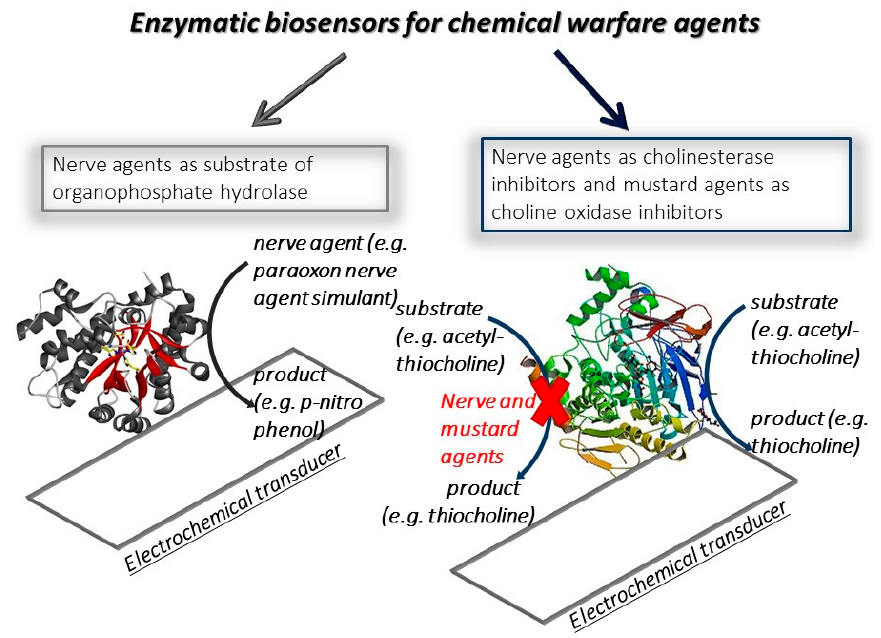
Figure 1. Scheme of enzymatic biosensor types for the detection of chemical warfare